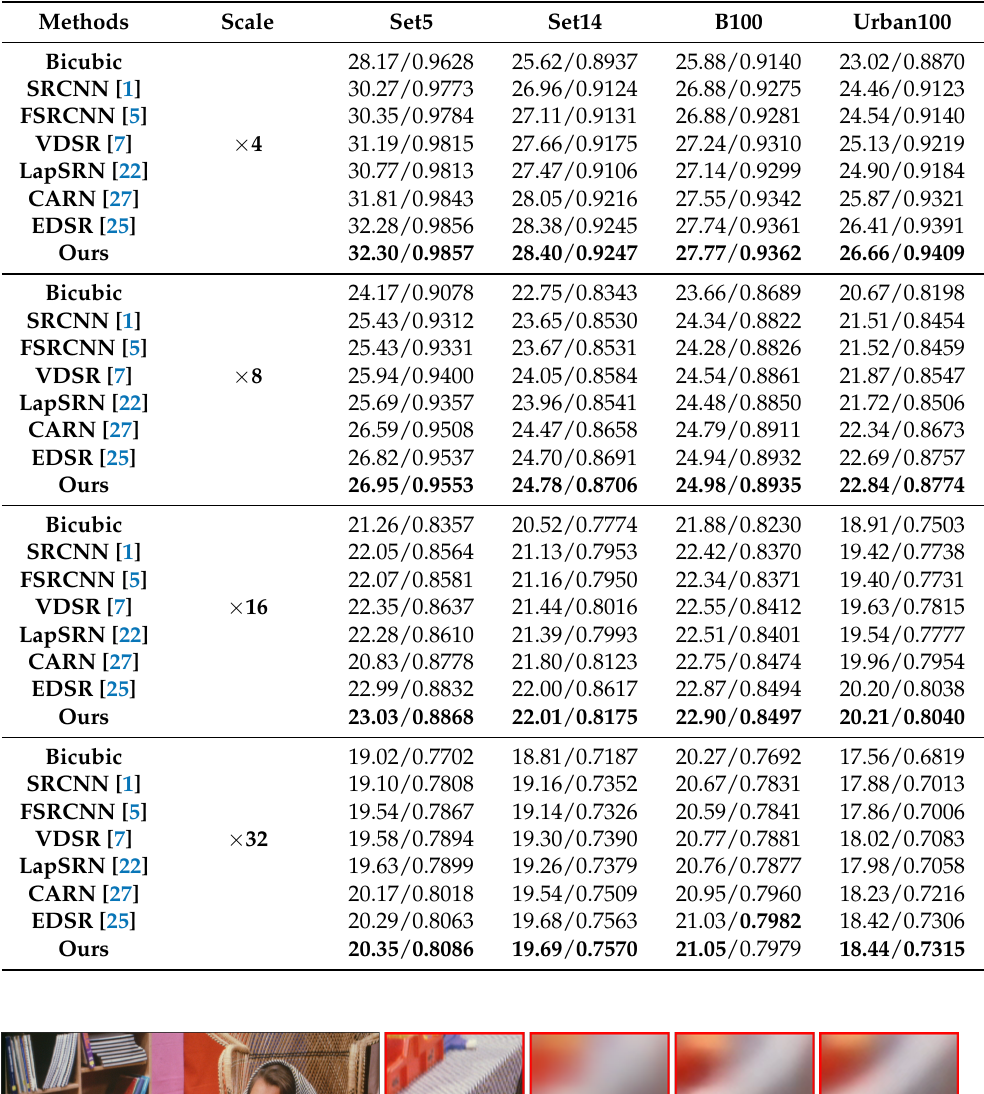
Table 5. PSNR and SSIM values of reconstruction results of different methods in different datasets.